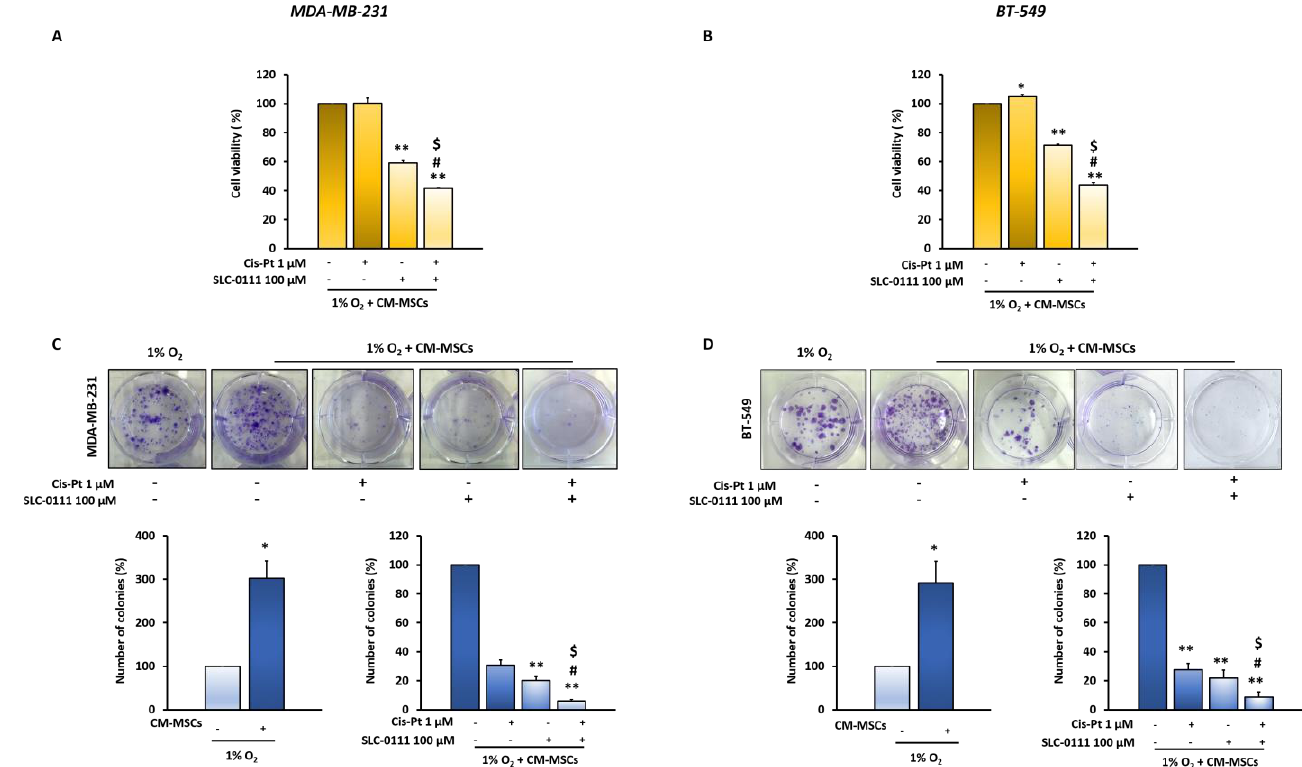
Figure 2. The combined treatment of SLC-0111 and Cis-Pt drastically reduces CM-MSC-induced TNBC cell viability and proliferation. Cell viability assay and clonogenic assay of MDA-MB-231 ( A , C ) and BT-549 ( B , D ) cells treated with Cis-Pt (1 µ M), SLC-0111 (100 µ M), alone or in combination, under hypoxic conditions (1% O 2 ) and in the presence of CM-MSCs for 72 h and 10 days, respectively. All the data are expressed as percentages, considering the untreated control cells as 100%. Bars depict mean ± SD of three independent experiments (vs. untreated ** p < 0.0001, * p < 0.001; vs Cis-Pt $ p < 0.0001; vs. SLC-0111 # p <